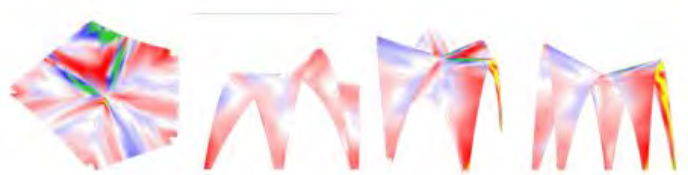
Figure 6. Karamba structural analysisshowing areas of compression (Red), tension (Blue), maximum tension (green),maximum compression (yellow), and neutral areas (white).